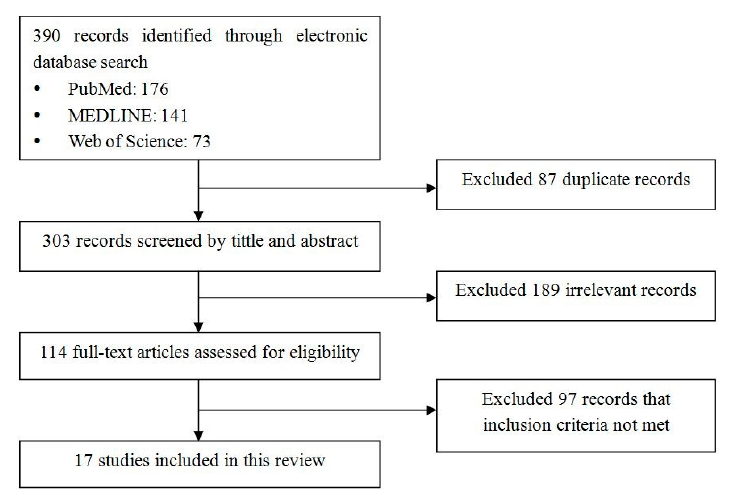
Figure 1. Flowchart for review of studies on facilitators and barriers of smokers’ compliance with smoking bans in public places.